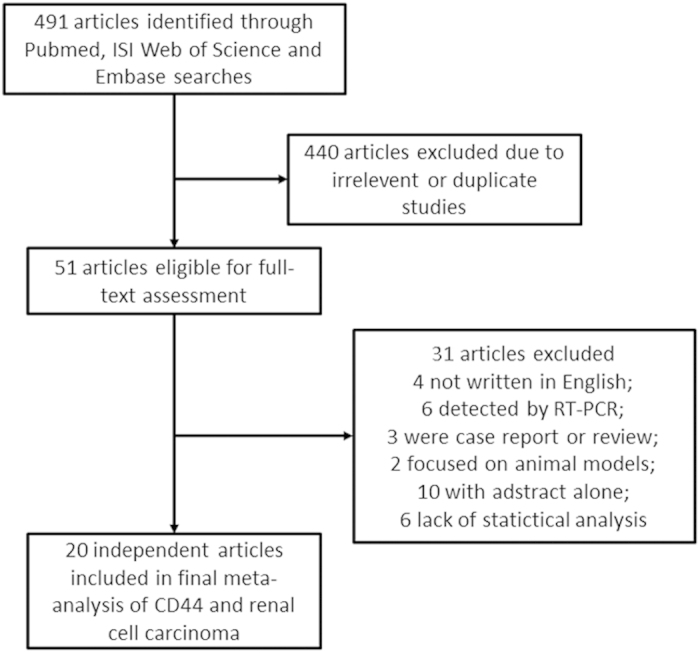
Flowchart of selection of studies for inclusion in meta-analysis.